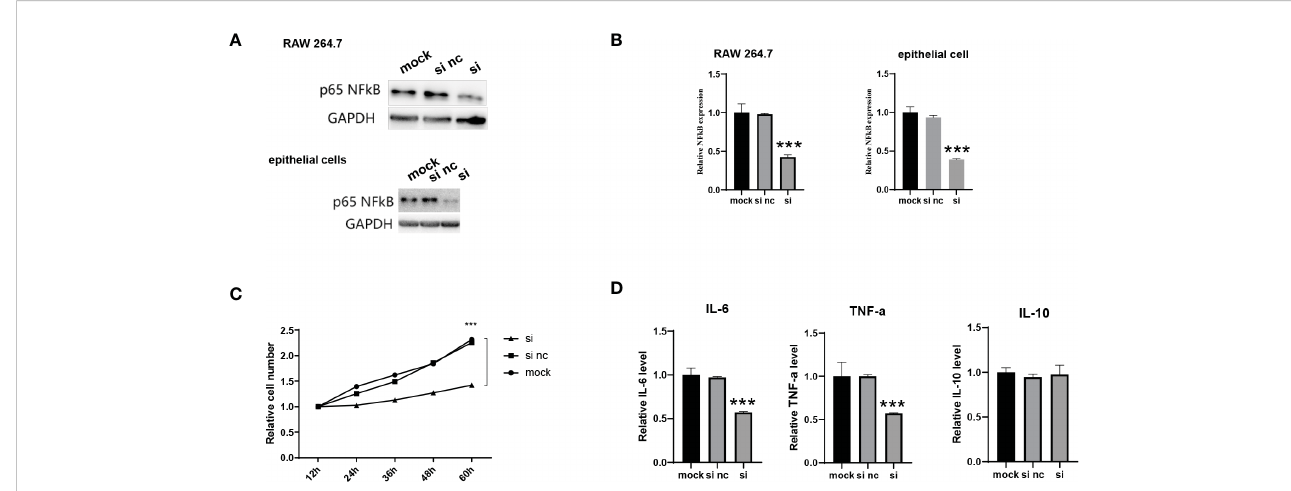
FIGURE 3 Evaluation of the activity of NF- k B siRNA-encapsulating exosomes in vitro . (A, B) The NF- k B protein (A) and mRNA (B) level of primary macrophages cells (RAW 264.7) and epithelial cells after incubating with si-ADMSC-EXOs (si) and nc-ADMSC-EXOs (si nc). (C) CCK-8 assay of RAW 264.7 cells after incubating with si-ADMSC-EXOs (si) and nc-ADMSC-EXOs (si nc). (D) ELISA assay of IL-6, TNF- a and IL-10 level in RAW 264.7 cells after incubating with si-ADMSC-EXOs (si) and nc-ADMSC-EXOs (si nc). *** p